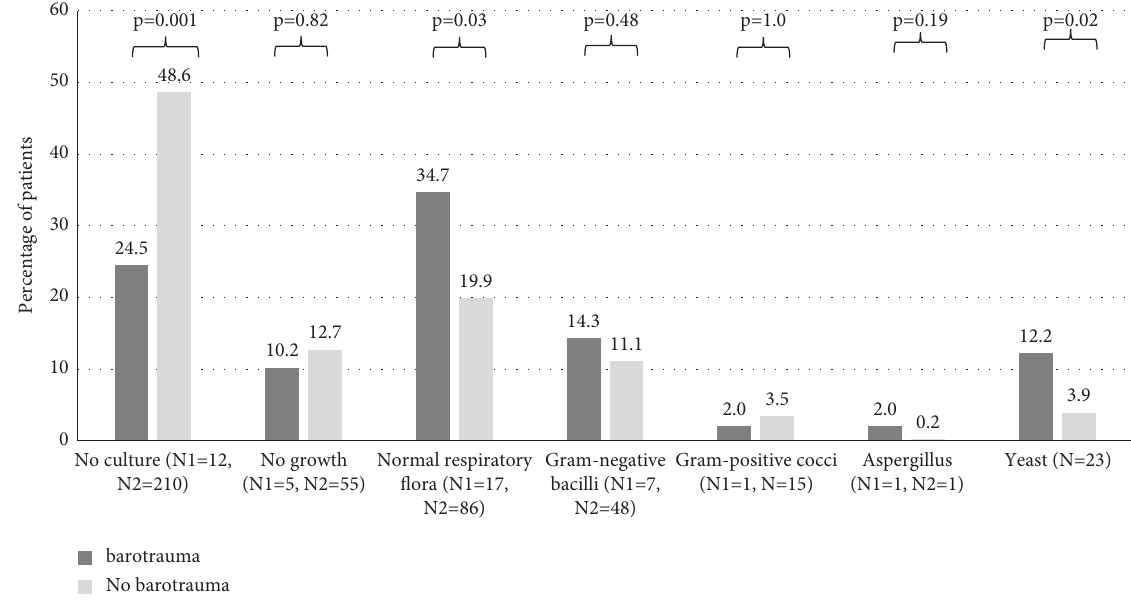
Figure 2: Results of respiratory bacterial cultures from patients with and without pulmonary barotrauma. N 1 refers to the number of patients with barotrauma who had the corresponding culture. N 2 refers to the number of patients without barotrauma who had the corresponding culture. Te percentage of patients with positive cultures is shown on the Y